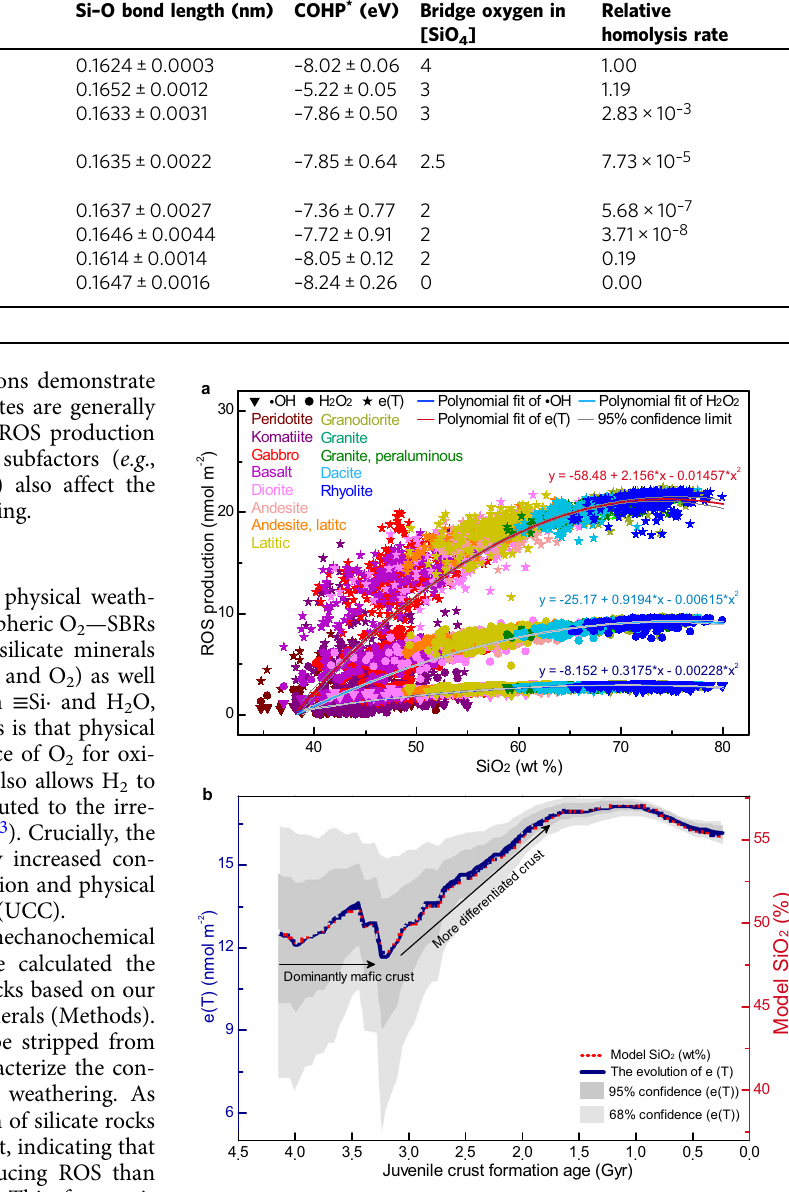
Fig. 2 Change in ROS-producing capacity of silicates during the evolution of Earth ’ s continents. a The correlation between estimated ROS production and SiO 2 in crustal rocks based on a compilation of 2632 reported magmatic rocks (see Supplementary Dataset). Data from GEOROC (ref. 93 ). The triangle, circle and star are ·OH production, H 2 O 2 production and e(T), respectively, while each color corresponds to a certain silicate rock. b Historical changes in e(T) during physical erosion and weathering of silicate rocks in juvenile crust (the change of SiO 2 content was obtained from Dhuime et al. 44 ). The e(T) in physical weathering of silicate rocks in juvenile crust is calculated by bringing the model SiO 2 into the equation of e(T) in Fig. 2a.